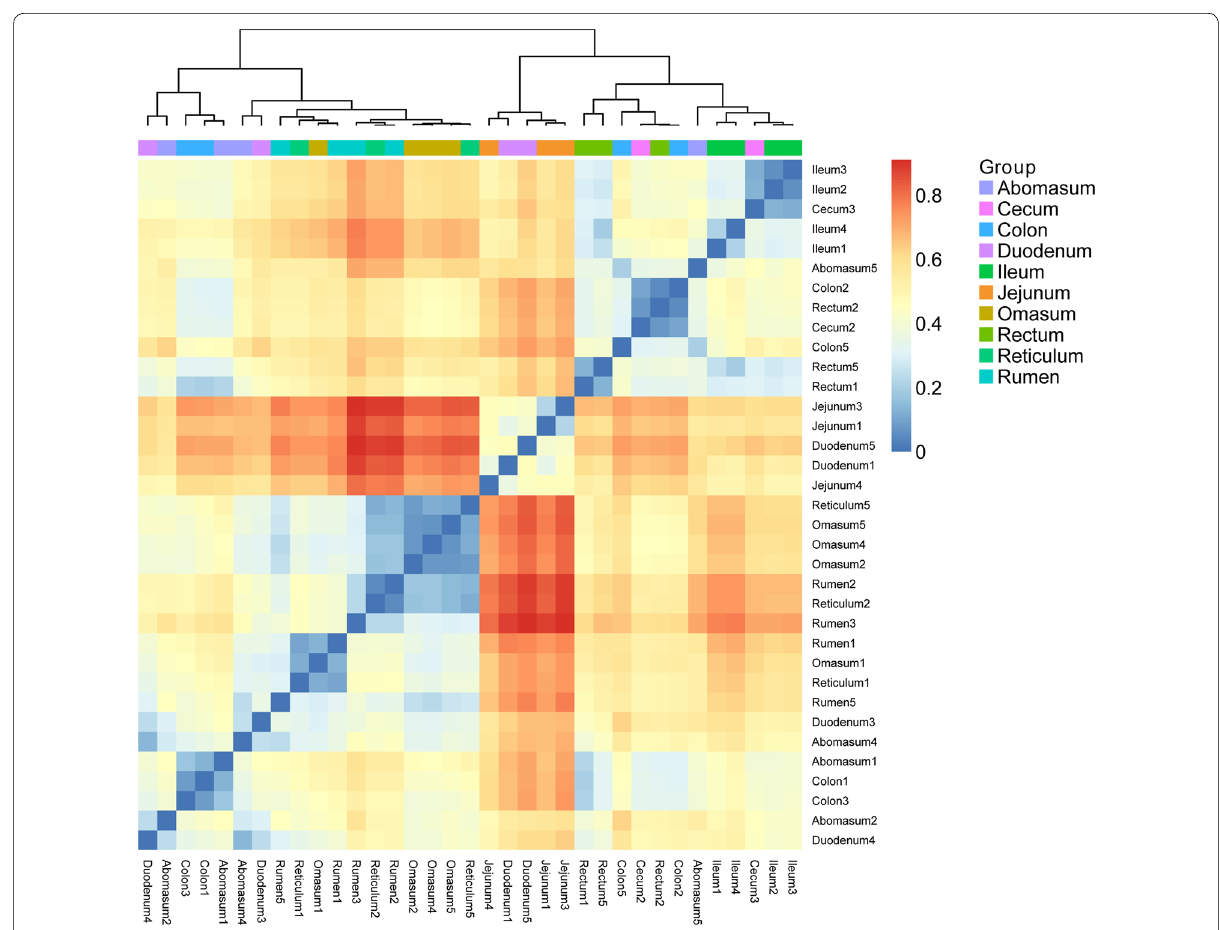
Fig. 2 The heatmap of beta diversity of samples. The different color intensities represent the relative bacteria abundance in each sample. The num- ber following the sample names stand for the sheep number. For example, reticulum 1, reticulum 2, reticulum 3, reticulum 4, and reticulum 5 stands for the reticulum samples from the 1st, 2nd, 3rd, 4th, and 5th